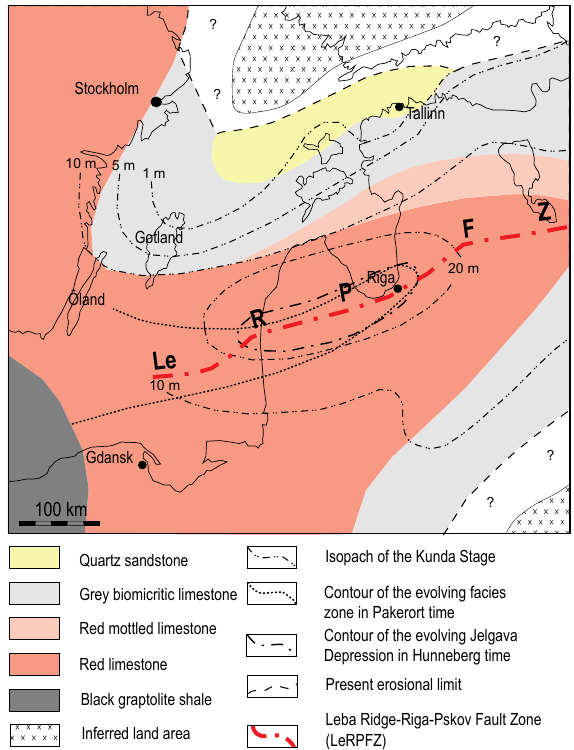
Fig. 3. Distribution and thicknesses of the facies of the Ordovician Darriwilian (Kunda) sediments within the Baltic Basin (modified after Männil 1966), the location of the LeRPFZ and the contours of the earliest Ordovician Livonian Tongue and Jelgava Depression during the Tremadocian (Pakerort) and at about the Tremadocian–Floian (Hunneberg) transition,